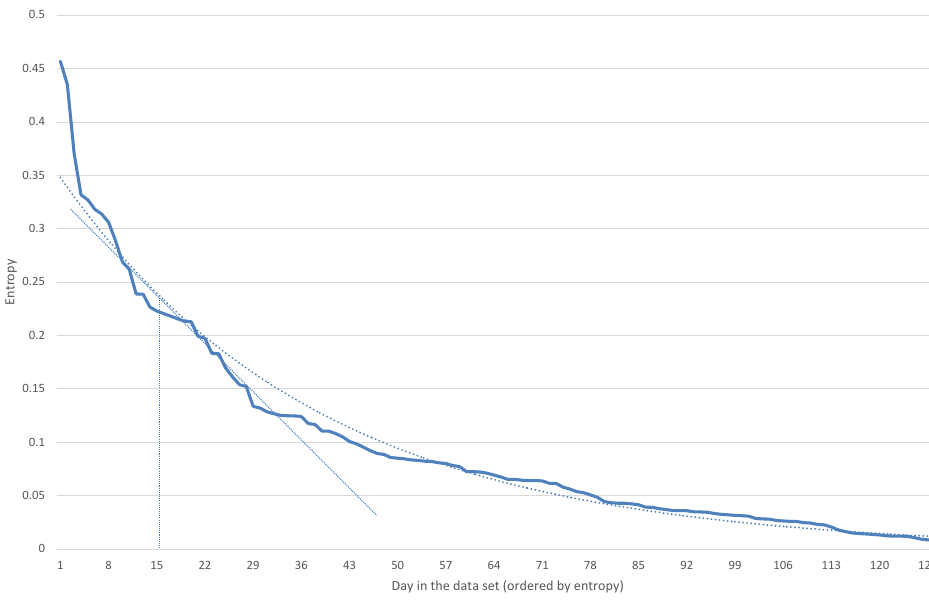
Day in the data set (ordered by entropy)